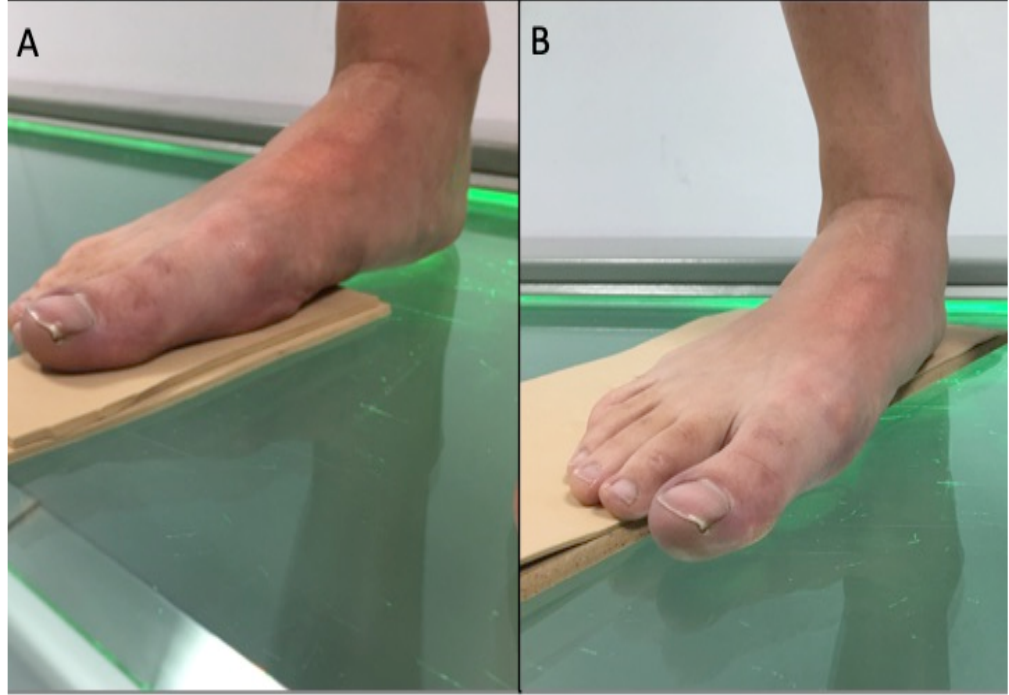
Figure 2. Foot positioning for AP radiographs ( A ): First ray dorsiflexion; ( B ): First ray plantarflexion. Three anterior-posterior (A-P) radiographs of the foot were obtained, with the first ray maximally dorsiflexed, maximally plantarflexed and in a neutral position, using the aforementioned blocks. These radiographs were used to quantify the range of motion of the first ray in the sagittal, frontal and transverse planes.